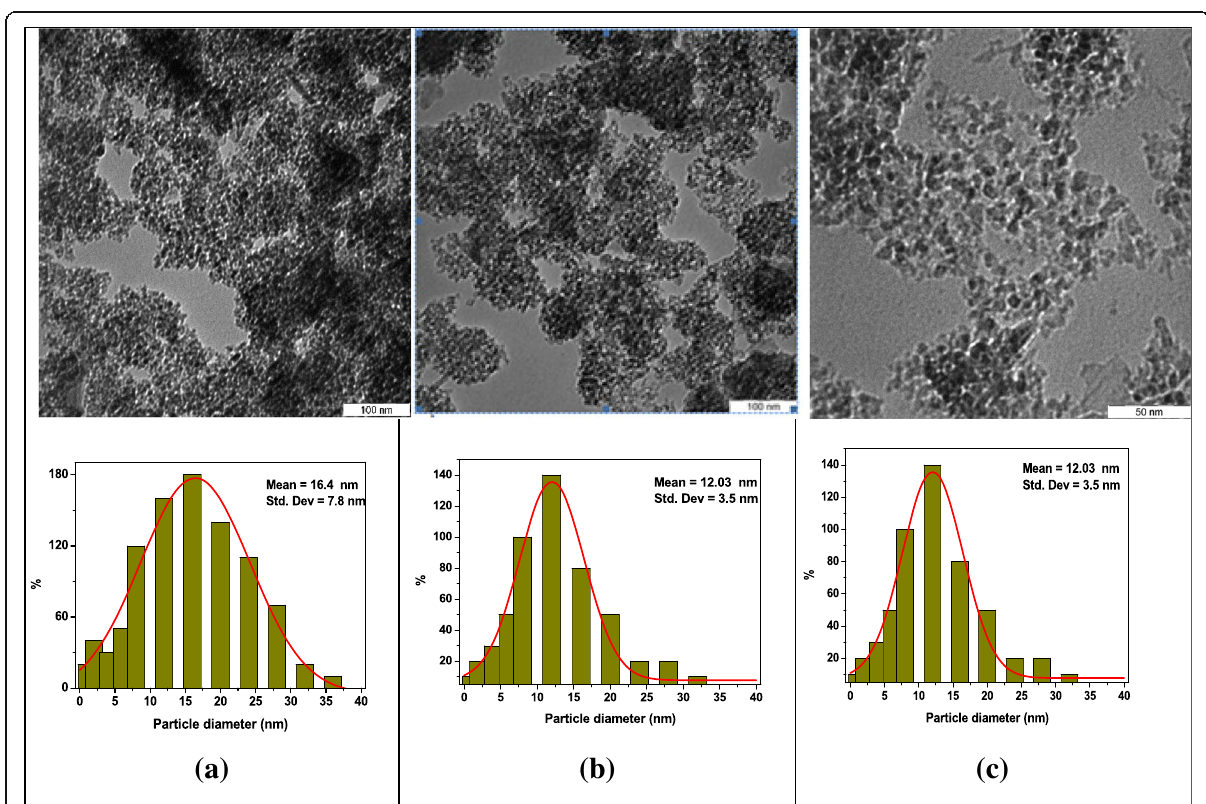
Fig. 5 The TEM images and the relative size histograms of the Al 2 O 3 -NPs a before (16.4±7.8nm) and after laser irradiation, at b 10min (14.2±5.4nm), and at c 30min (12.03±3.5nm),